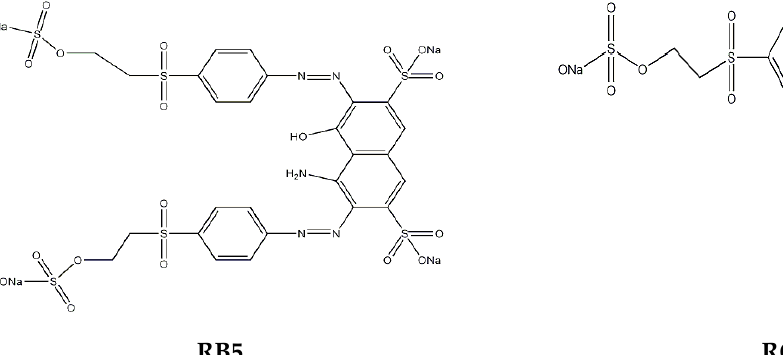
Figure 3. Structure of RB5 and RO16.